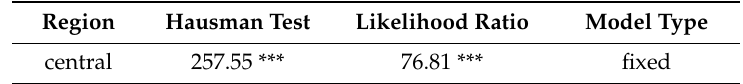
Table 5. Results of the Hausman test and the likelihood ratio test.